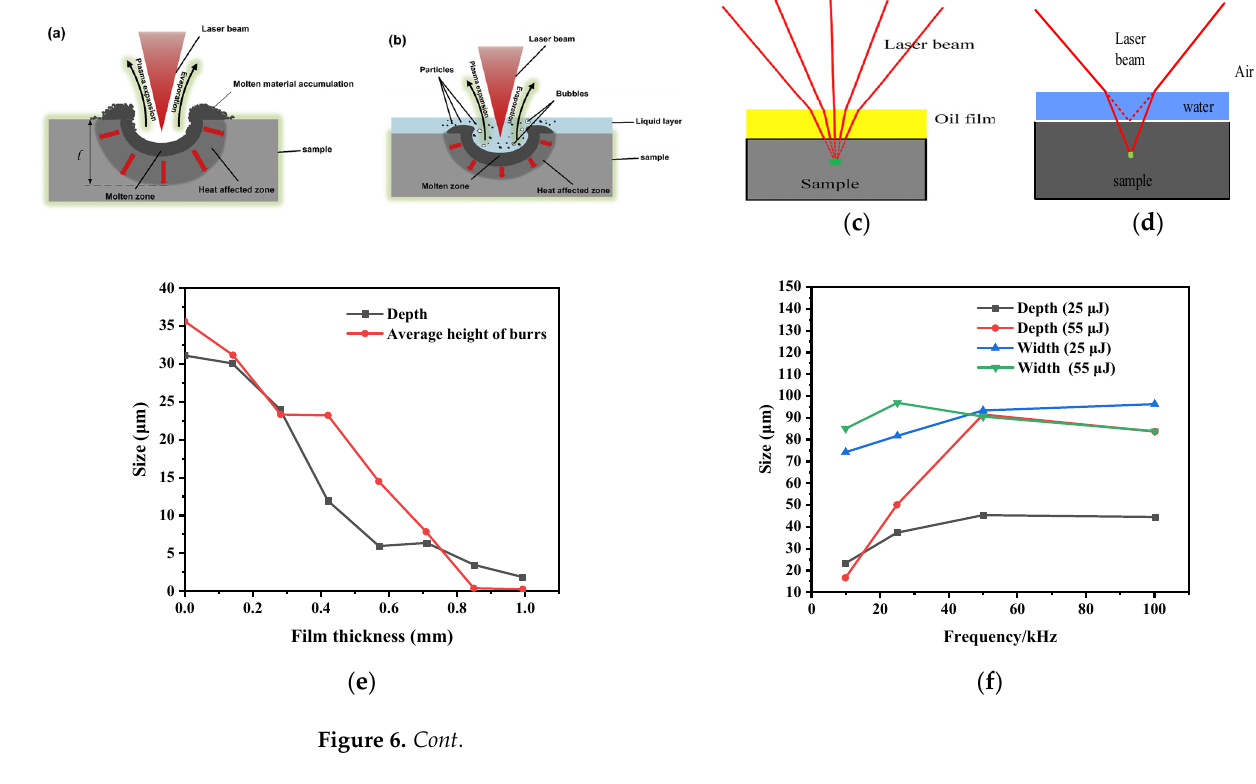
( h ) Figure 6. Schematic of laser ablation’s effect on the material: ( a ) in air; ( b ) with a liquid layer, re- printed with permission from [49], Copyright from Elsevier 2020; the change of the focus point in- duced by the optic effect of liquid layer; ( c ) in oil; ( d ) in water, reprinted with permission from [88,94], Copyright from Elsevier 2020, 2016; ( e ) ablation size volume of craters created on with oil film layer, reprinted with permission from [88], Copyright from Elsevier 2020; Sample depths and widths at various: ( f ) frequencies; ( g ) pulse energies; and ( h ) scanning numbers [100].